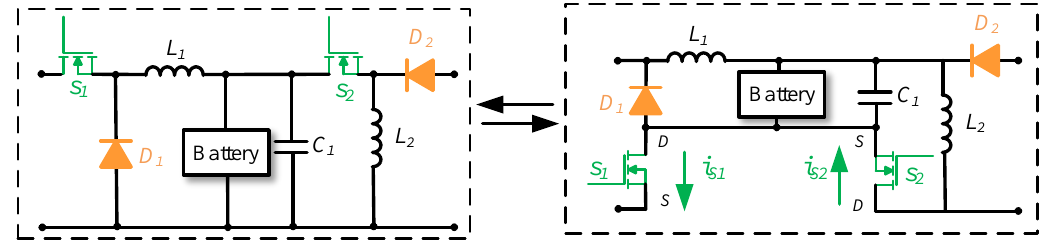
Figure 5. Equivalent electrical circuits with common drain-source node.